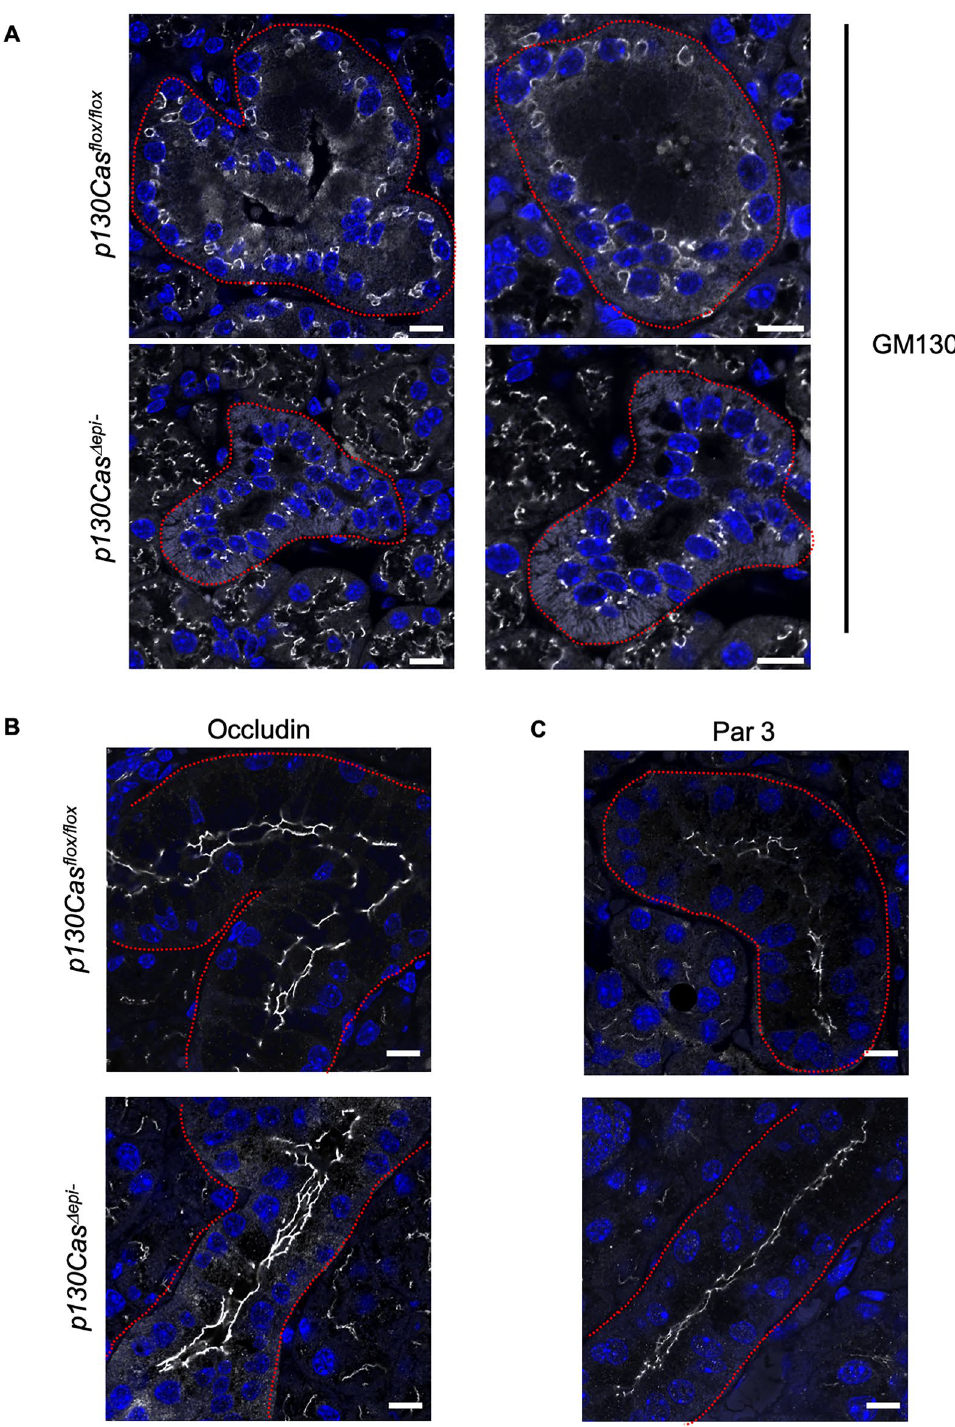
Figure 6. Tissue polarity was not compromised by the absence of p130Cas in the SMG. ( A – C ) Representative immunofluorescence staining images of SMG paraffin sections using anti-GM130 (grey) ( A ), anti-occludin (grey) ( B ) and anti-Par3 (grey) ( C ) antibodies. Nuclei were counterstained using Hoechst 33,342. Areas surrounded by dotted lines indicate GCT. Scale bars = 10